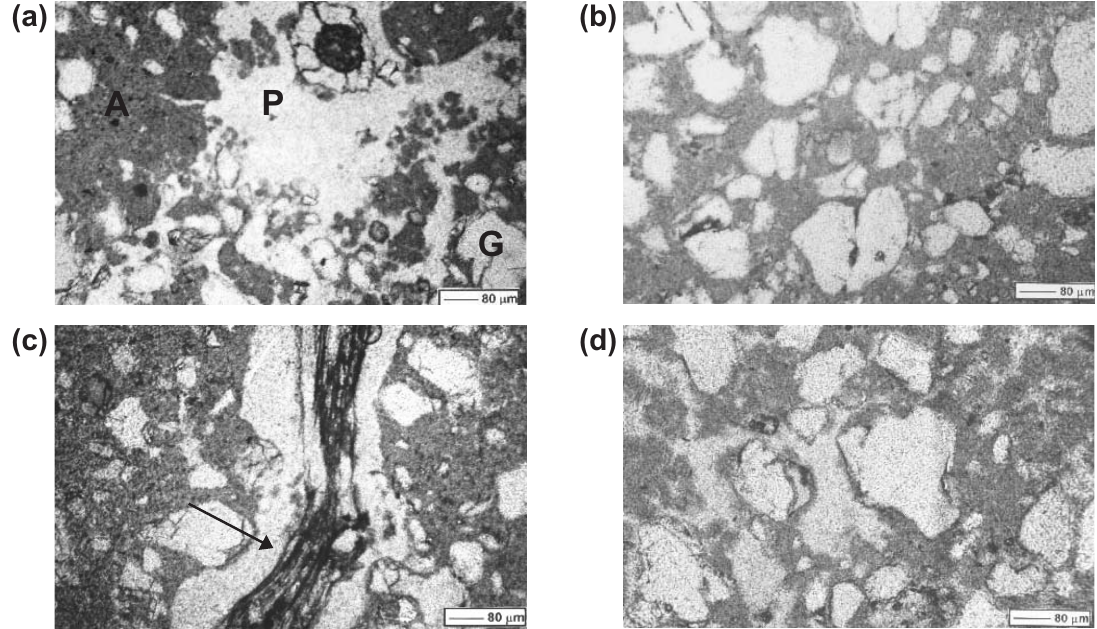
Figura 4. Micrografias obtidas por microscópio petrográfico em amostras de um Latossolo Amarelo: (a) horizonte A (não-coeso), mostrando estrutura granular, com agregados rodeados por macroporos; (b) horizonte BA (coeso) com aspecto maciço na matriz do solo, com predomínio de microporos; (c) penetração de raiz (seta) no topo do horizonte BA (coeso); (d) horizonte Bw2 (não-coeso), mostrando estrutura em blocos subangulares, com aspecto menos adensado que o horizonte BA. P = poro; A = agregado; G = grão de